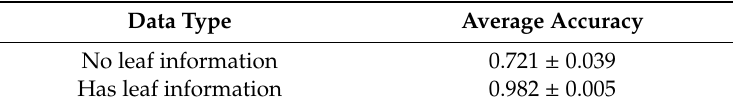
Table A2. Five hundred citrus canker images and 500 pitaya canker images. Using AlexNet to compare the classification accuracy to determine whether to use leaf information. We gathered statistics for 10 training exercises, and the di ff erence was statistically significant ( p < 0.05). We compared the Pearson correlation coe ffi cients of citrus canker and pitaya canker. for the no leaf information case, the Pearson correlation coe ffi cient was − 0.7121. For the has leaf information case, the Pearson correlation coe ffi cient was − 0.5824. It confirmed that our sample accuracy was independent.